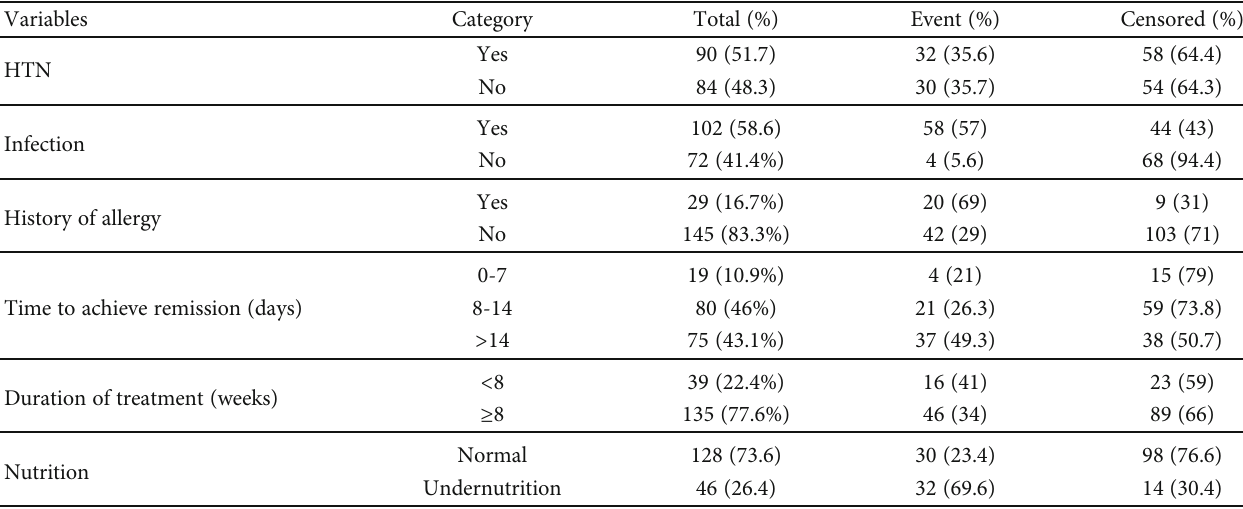
Table 2: Disease-related characteristics of children with nephrotic syndrome in comprehensive specialized hospitals of Tigray region, Northern Ethiopia, 2019 ( N = 174 ).